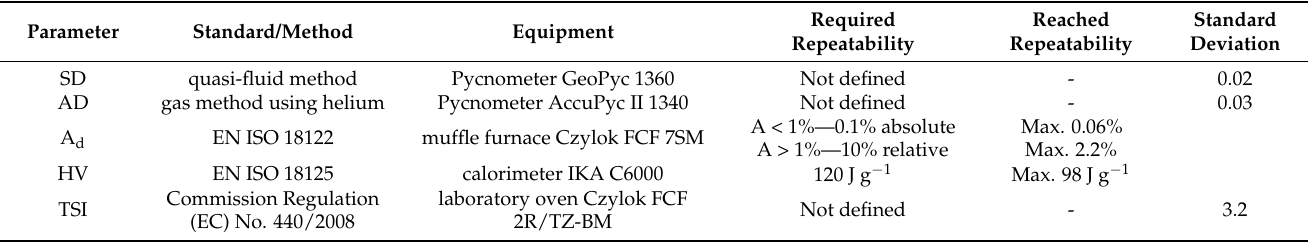
Table 3. Standards followed for biomass quality parameters and analytical equipment used with information on measure- ment